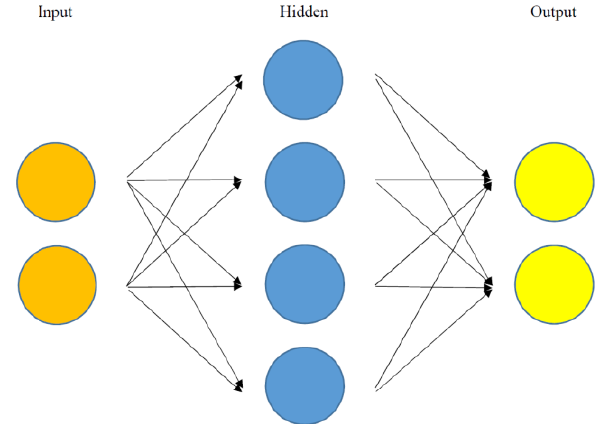
Figure 2. Structure of the artificial neural network. An artificial neural network is a network of input / output units (so called “neurons”) connected through weights. The artificial neural network usually consists of one input layer, one, two or three hidden layers, and one output layer. Neurons in a previous layer combine with “weights” in the next layer (here, the weights are numerical values showing how much effect neurons in a previous layer have on neurons in the next layer).